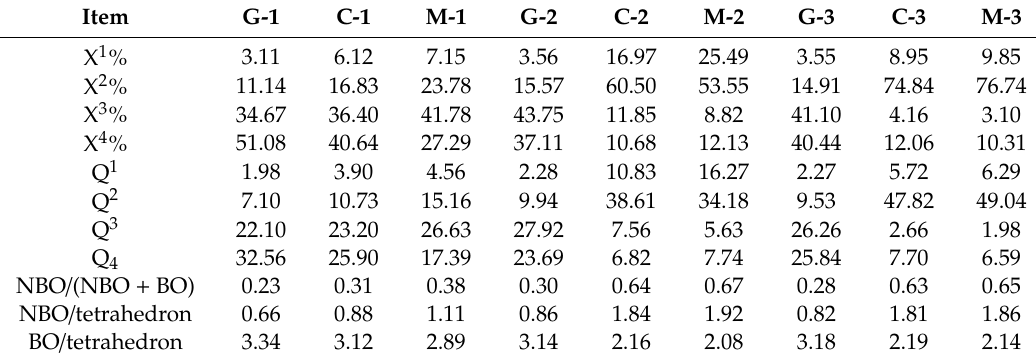
Table 4. Fraction (X n %) and content (Q n ) of structure units, fraction of non-bridging oxygen, average number of NBO per tetrahedron, and average number of bridging corners per